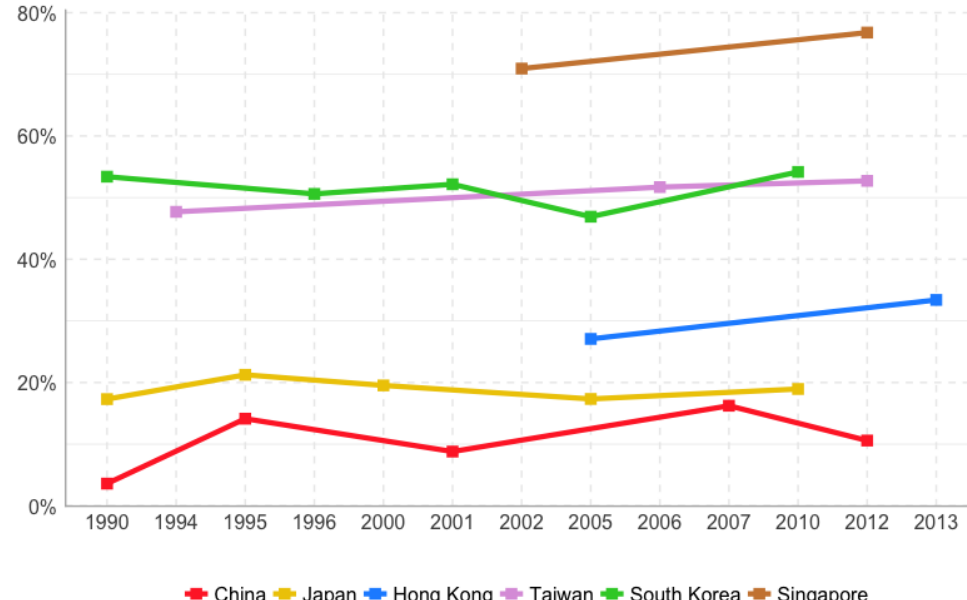
Figure 2. Percentage of respondents who say religion is important in East Asian societies (World Values Surveys, weighted).